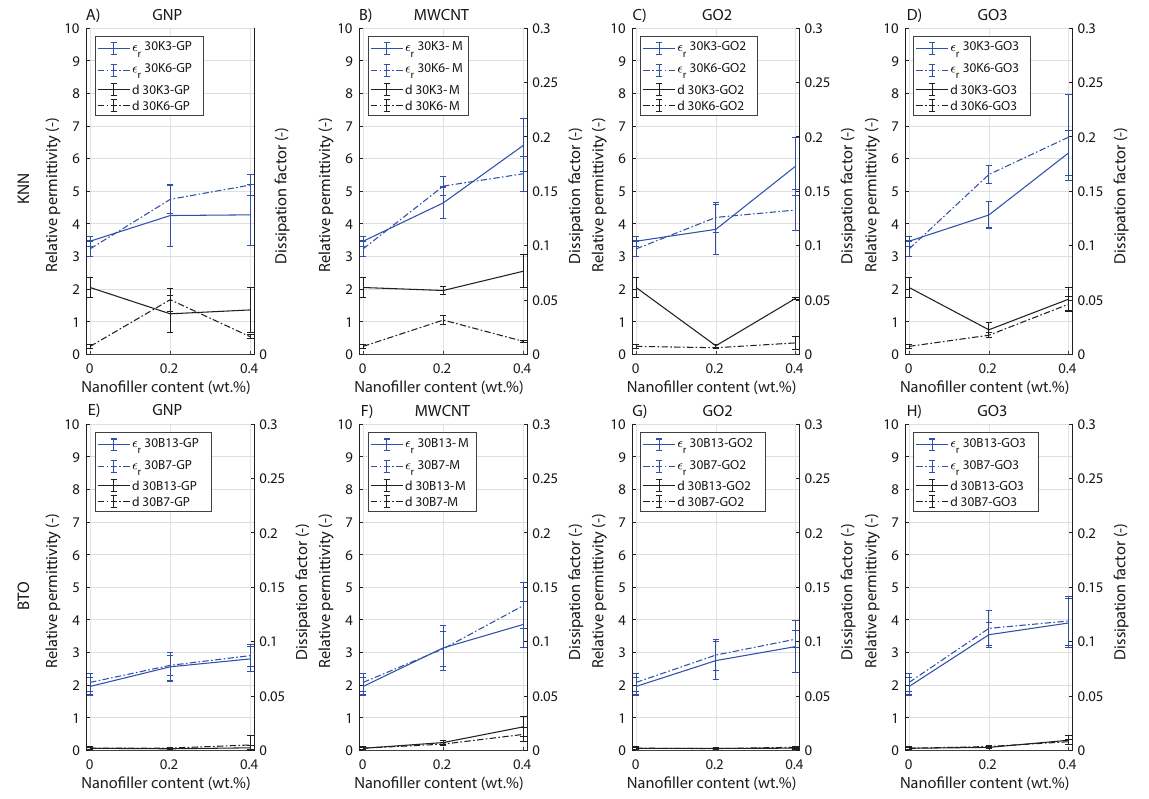
Figure 3. Room temperature relative permittivities ε r and dielectric losses (dissipation factors tan δ ) of all piezoelectric composites made in this study at 1 kHz. The data are not comparable with the literature since no electrodes were applied to the composites. Measurement points are joined with linear lines for visual purposes only and do not present a linear